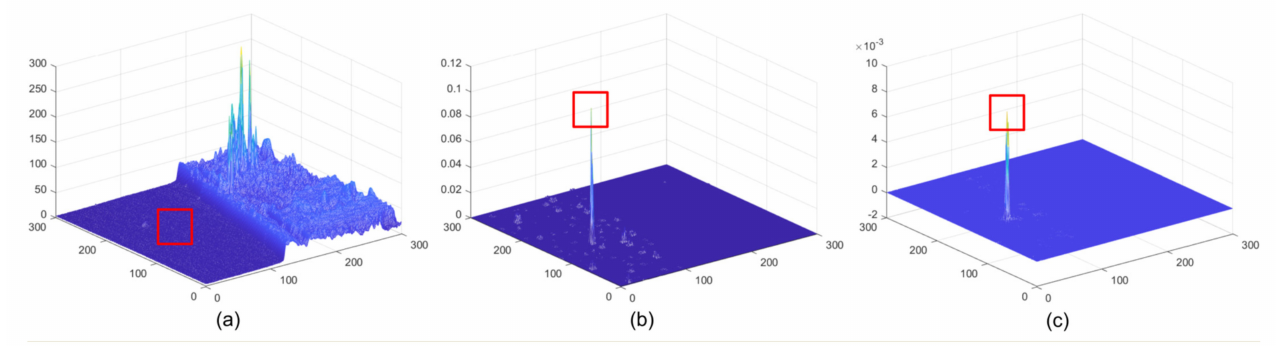
Figure 5. ( a ) Three-view of raw image; ( b ) three-view of the result after spatial–temporal matching; ( c ) three-view of the saliency map.